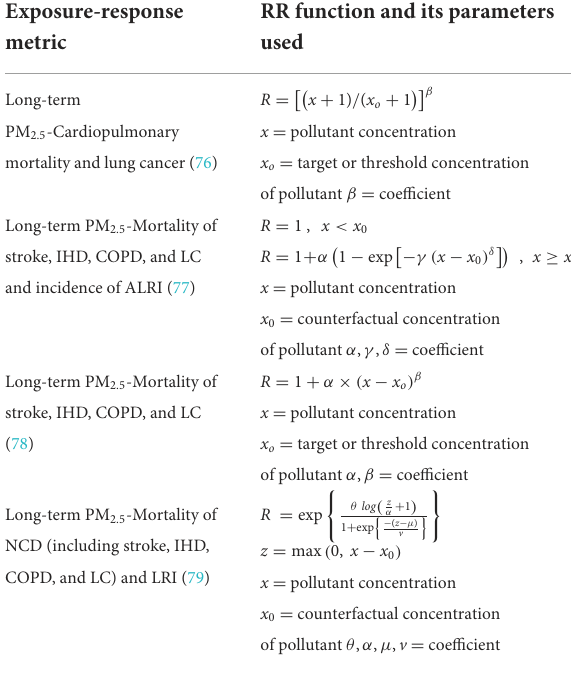
TABLE 1 Existing RR models used for assessing burden of